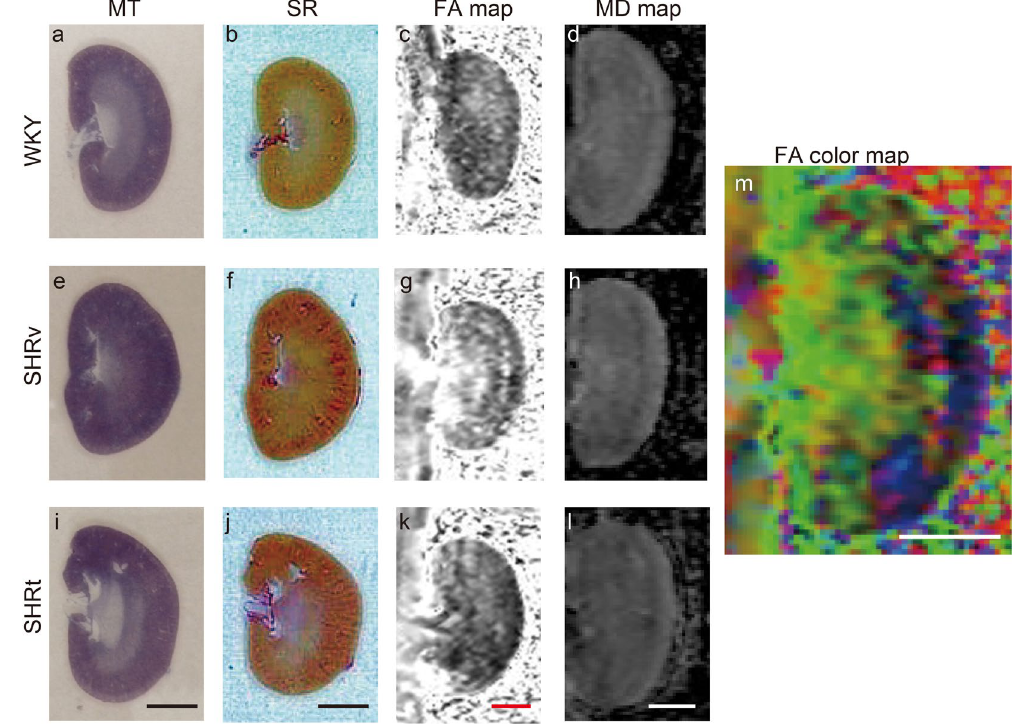
Figure 3. Visualization of RF in FA maps. ( a – l ) Images of Masson Trichrome (MT) ( a , e , i ), Sirius Red (SR) ( b , f , j ), FA map ( c , g , k ), and MD map ( d , h , l ) in kidneys from WKY rats, SHR/ND rats treated with vehicle (SHRv), and SHR/ND rats treated with telmisartan (SHRt). ( m ) FA color map of an SHRv kidney. Scale bars, 5